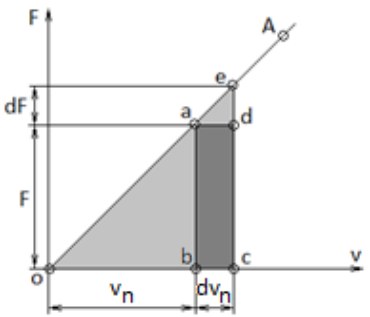
Figure 4. Representation of the external mechanical work ( dL ext ) produced by the loads applied to the beam.